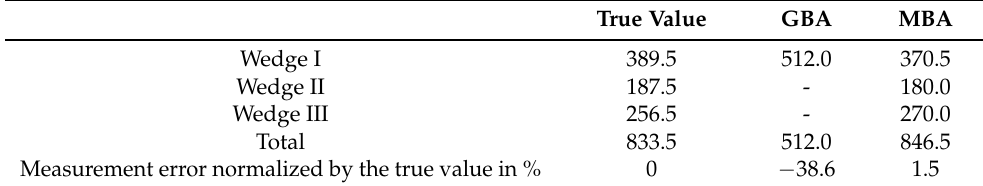
Table 2. Areas determined by the model-based algorithm (MBA) as well as the state-of-the-art, gradient-based algorithm (GBA) for the wedges in Figure 8. The area values are given in unit pixel 2 .